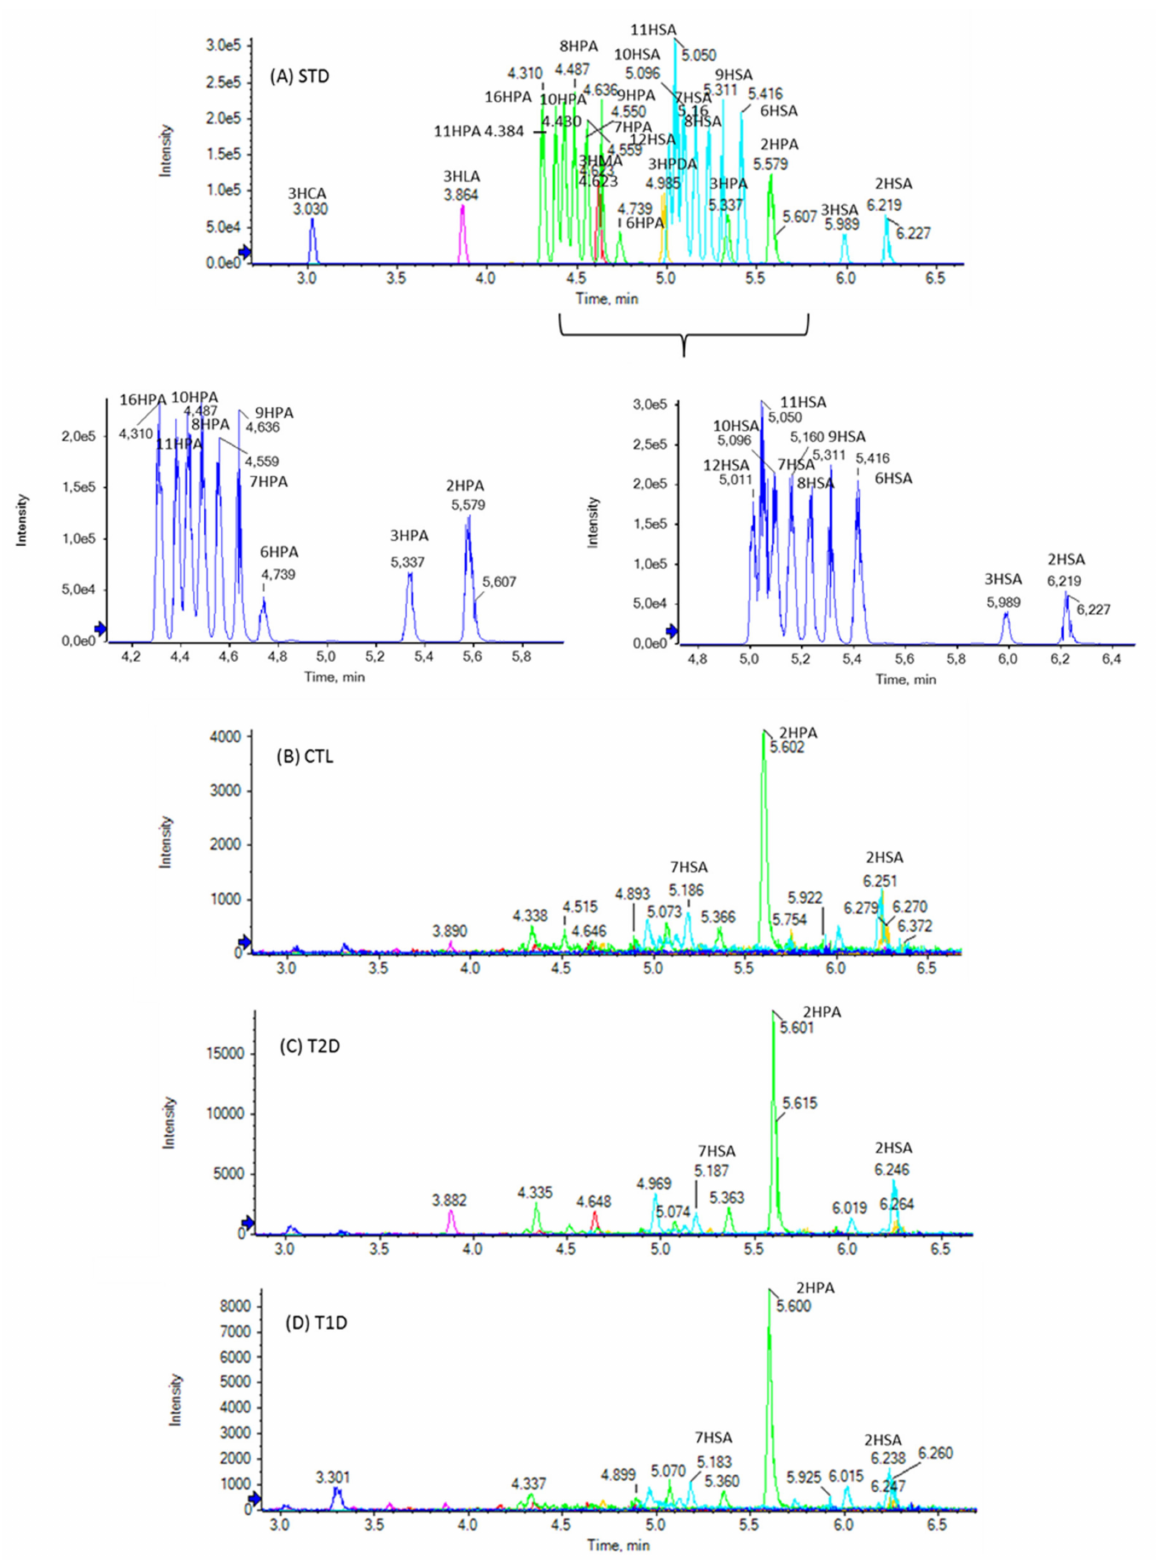
Figure 1. Extracted ion chromatograms (EICs) of SHFAs in a standard solution (500 ng/mL) ( A ), and in a representative control sample ( B ), a T2D sample ( C ), and a T1D sample ( D